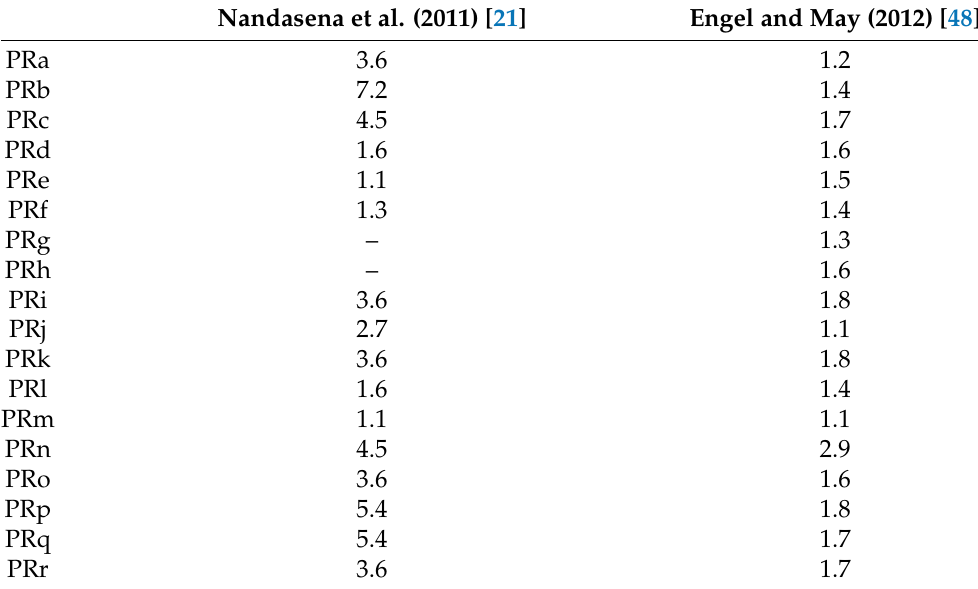
Minimumwave heights H m (m) required to displace the boulders of Punta Prosciutto headland.